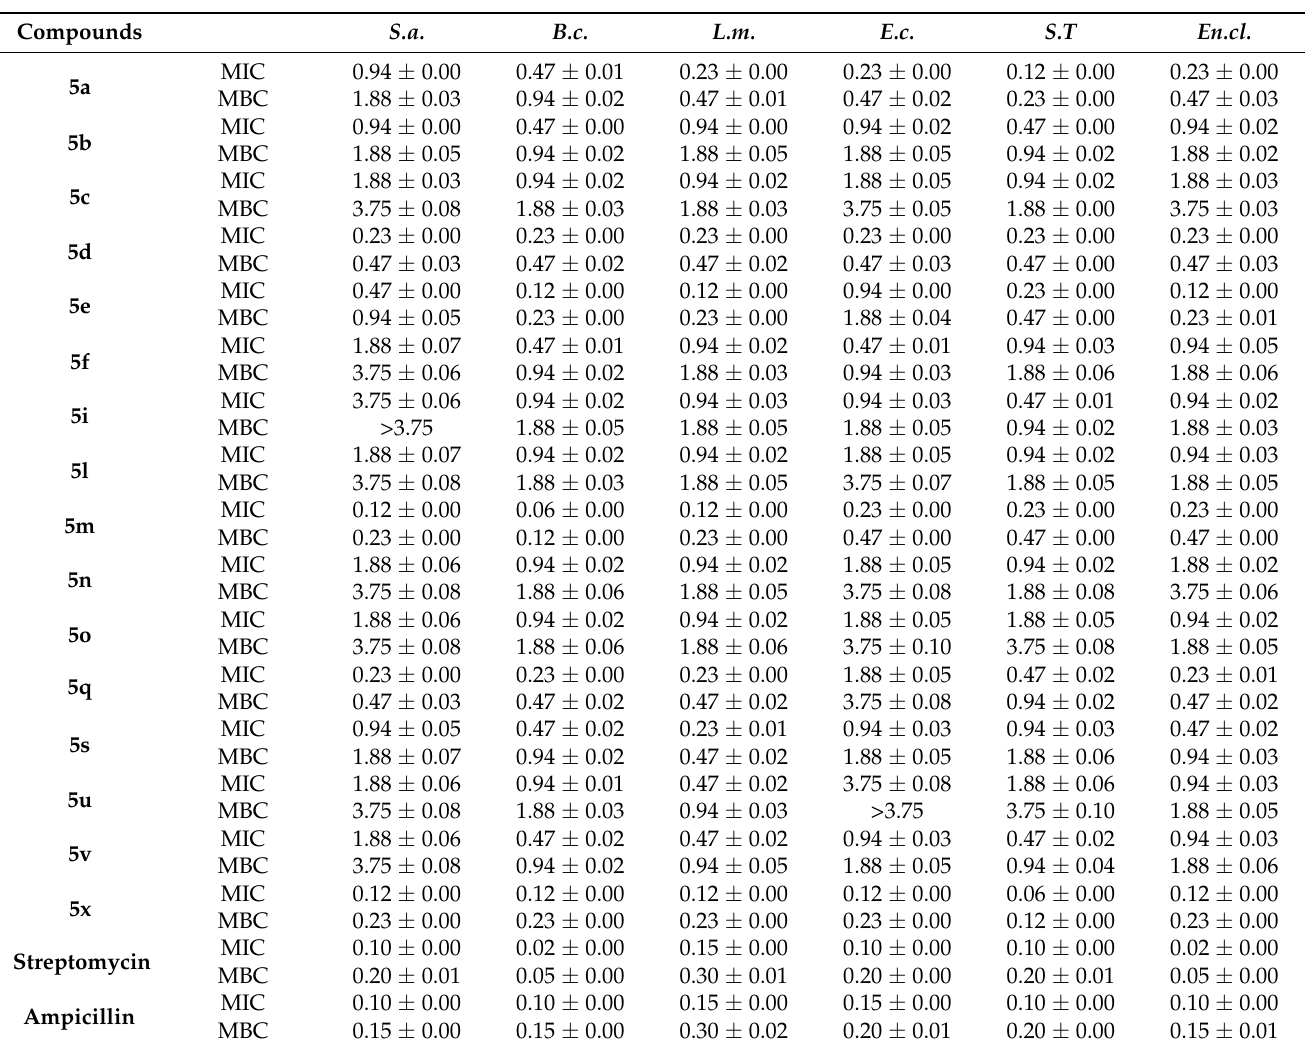
Table 1. Antibacterial activity of indole derivatives. (MIC and MBC in